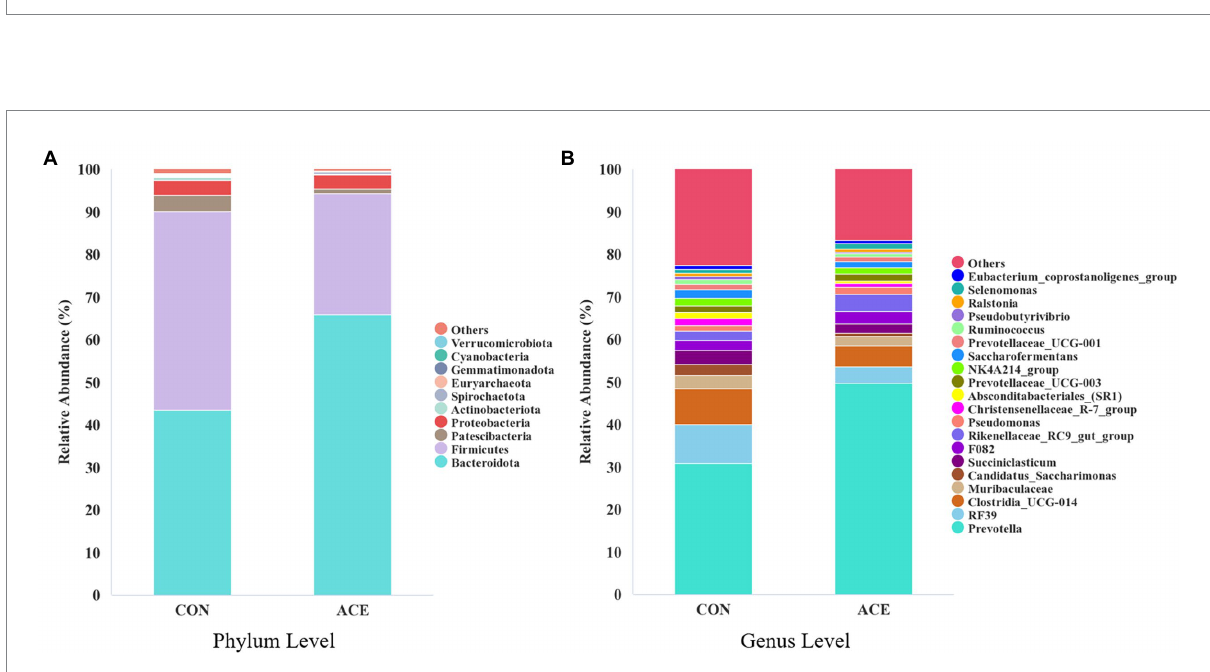
FIGURE 2 Distribution of rumen bacterial community composition in CON and ACE groups. (A) Phylum level; (B) genus level. CON = control group, basal diet plus 468 g/day oral sodium chloride; ACE = NAc group, basal diet plus 656 g/day oral